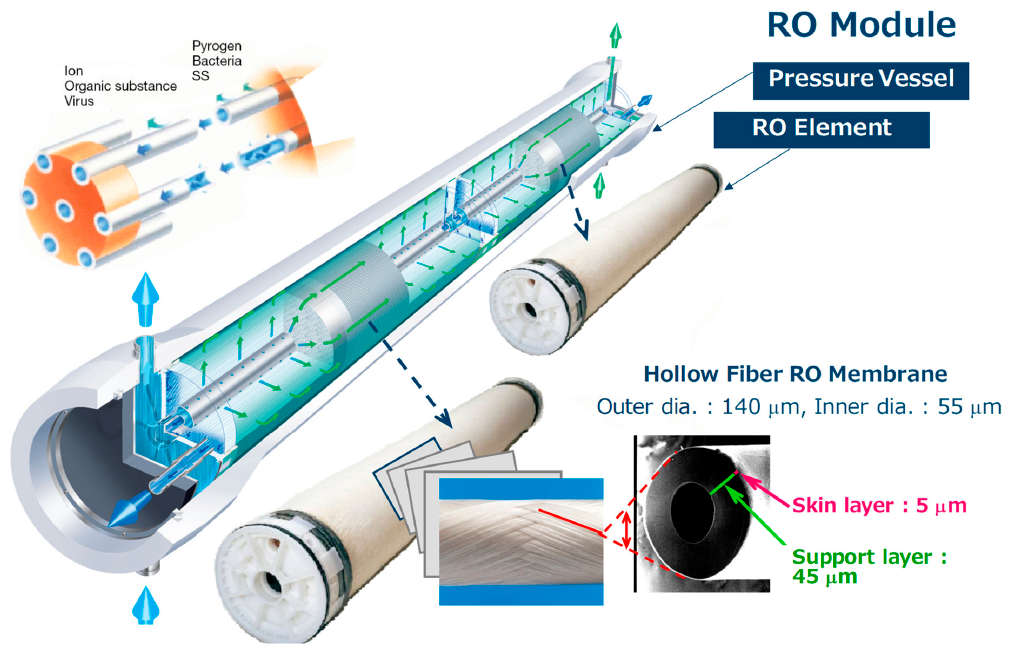
Figure 3. Structure of cellulose triacetate (CTA) reverse osmosis (RO) membrane module.